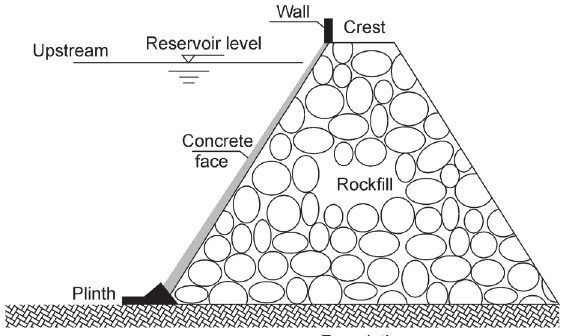
Figure 1 - Concrete face rockfill